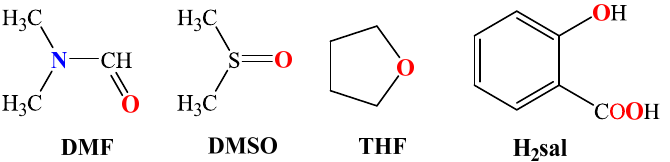
Figure 3. The syntax formula of oxygen donors: DMF = N,N –dimethylformamide; DMSO = dime- thylsulfoxide; THF = tetrahydrofuran and H 2 sal = salicylic acid.